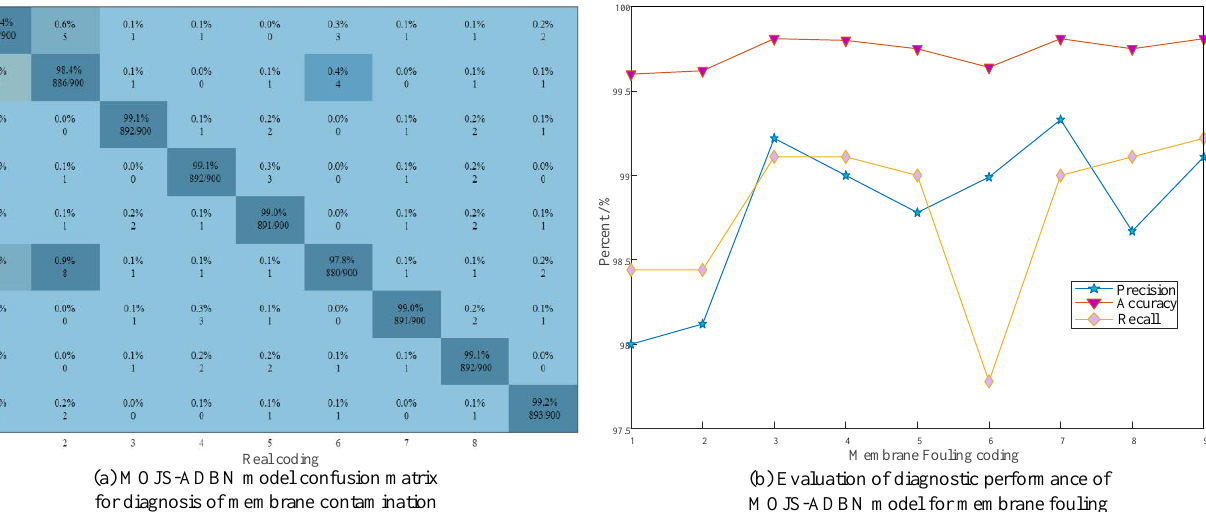
Figure 7. Performance of the MOJS-ADBN model in membrane fouling diagnosis.